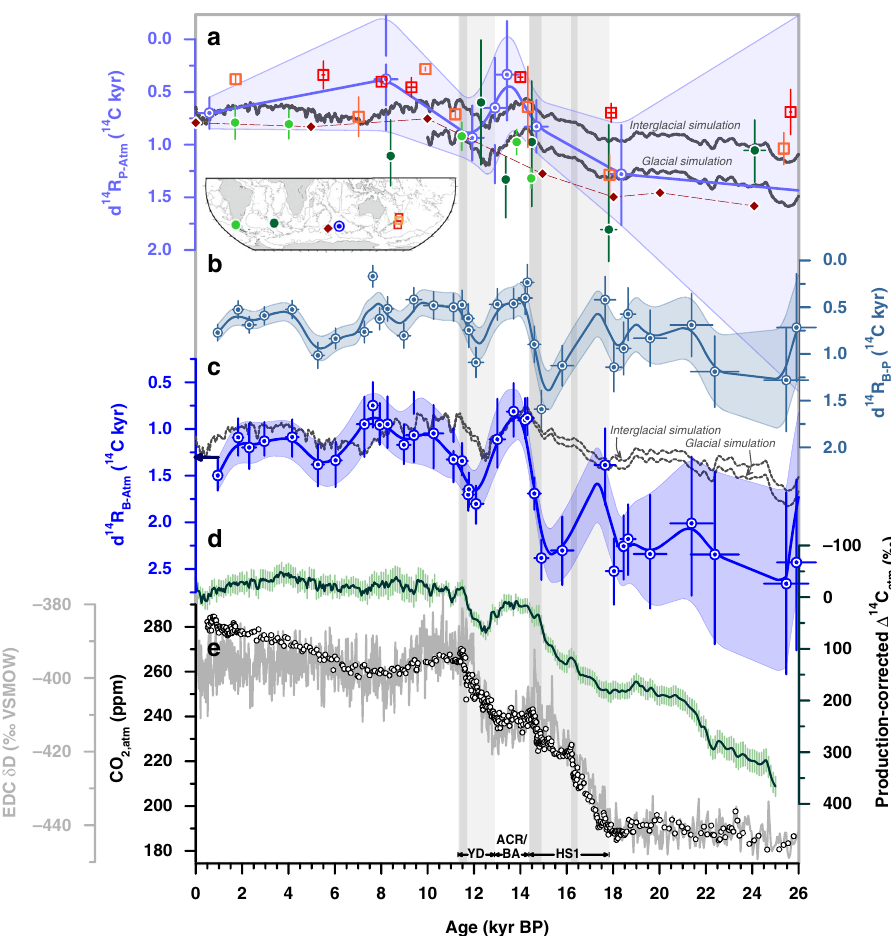
Fig. 4 Deglacial ocean reservoir age variations reconstructed in South Indian core MD12-3396CQ. a Surface-ocean reservoir age (d 14 R P-Atm ) constraints from the Southern Ocean for the deglacial and glacial periods: Chilean Margin (MD07-3088, light green, tephra-based) 7 , in the New Zealand area (orange 30 , red 31 , tephra-based), in the sub-Antarctic Atlantic (MD07-3076CQ, dark green, stratigraphic alignment between sea surface temperature (SST) and Antarctic temperature) 5 , and in the South Indian (MD12-3396CQ, light blue, stratigraphic alignment between (sub-)SST and Antarctic temperature). d 14 R P-Atm values for the Kerguelen Plateau adopted by ref. 16 are shown in dark red (for locations of cores see inset map), b benthic-to- planktic foraminiferal 14 C age offsets (d 14 R B-P ) in MD12-3396CQ, c 14 C age offsets of benthic foraminifera in MD12-3396CQ from the contemporaneous atmosphere, d 14 R B-Atm , d Δ 14 C atm variations corrected for changes in cosmogenic 14 C production 3 , and e atmospheric CO 2 (CO 2,atm ) changes (black symbols) 32 and EPICA Dome C (EDC) δ D variations (grey) 25,69 . Grey lines in a and c show simulated d 14 R P-Atm changes at the study site (80 – 100°E, 45 – 50°S; Methods 29 ) at 25 m and 3.5 km depth, respectively. Arrow in c indicates prebomb deep-ocean reservoir ages (1.3 14 C kyr) at our study site (according to the the Global Ocean Data Analysis Project database, version 2) 28 . Lines and envelopes show 1 kyr-running averages and the 1 σ -uncertainty/ 66%-probability range. Vertical bars indicate intervals of rising CO 2,atm levels (darker bands highlight periods with centennial-scale CO 2,atm increases 32